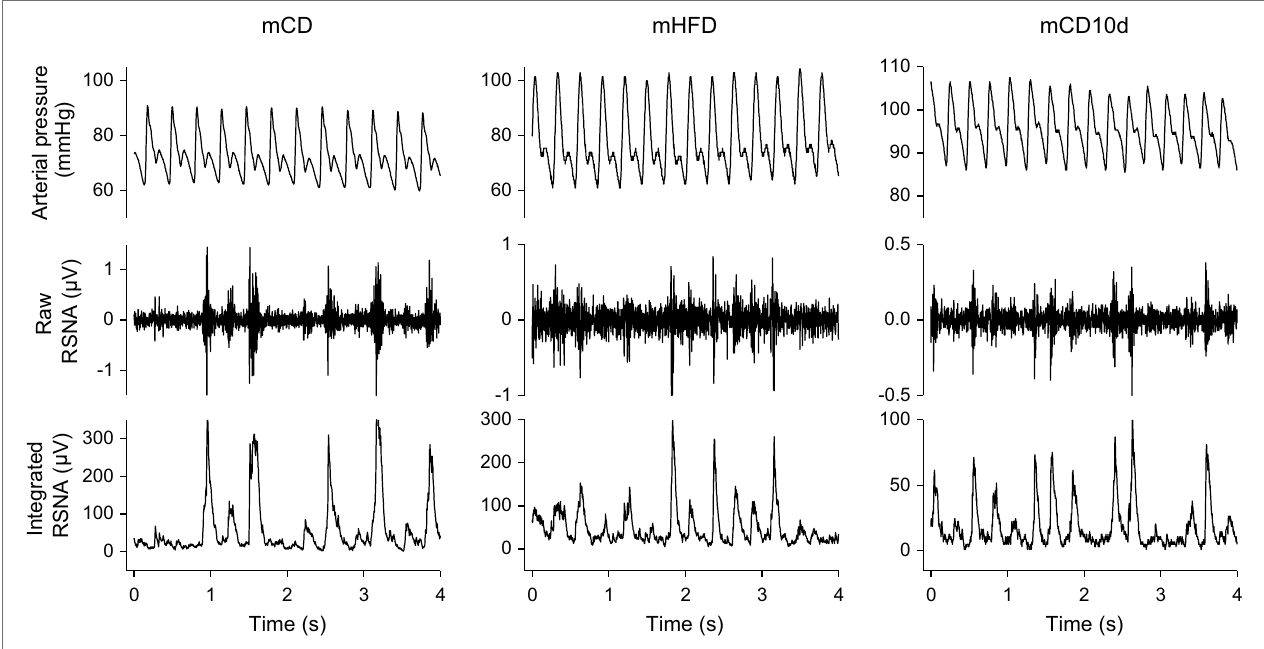
FIGURE 2 | Sections of records from individual mCD, mHFD, and mCD10d rabbits at rest. For each group, arterial pressure (top), raw renal sympathetic nerve activity (RSNA, middle), and integrated RSNA (bottom) are shown.